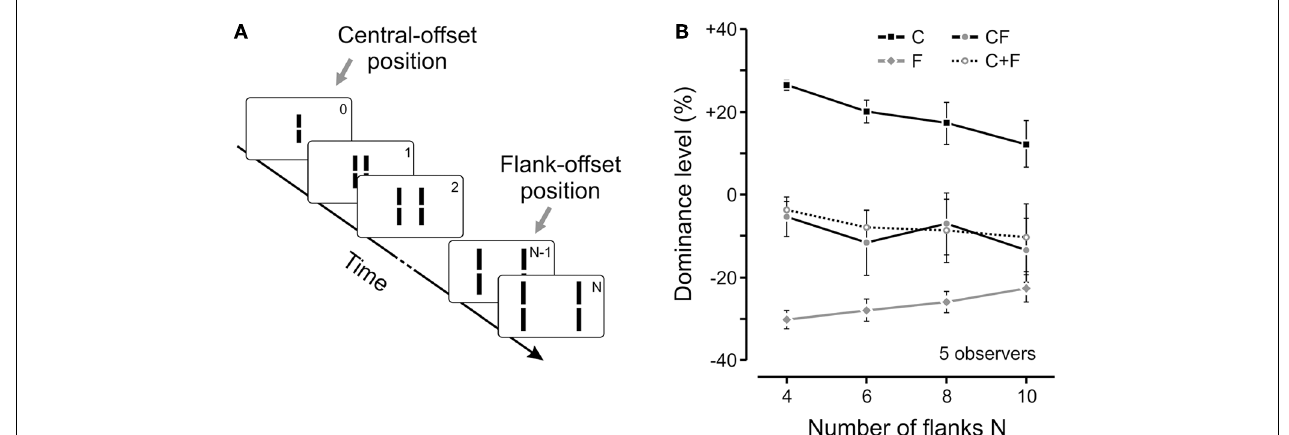
changed as it was always well predicted by the linear sum of performance levels in conditions C and F (see C + F). Notably, in the longest sequence, the distance between the central- and the flank-offset (which was presented in frame 9) was 0.5˚ with an SOA of 370ms. Hence, feature integration was not changed during a substantial spatio-temporal window. Copyright ©2009 by the American Psychological Association. Reproduced